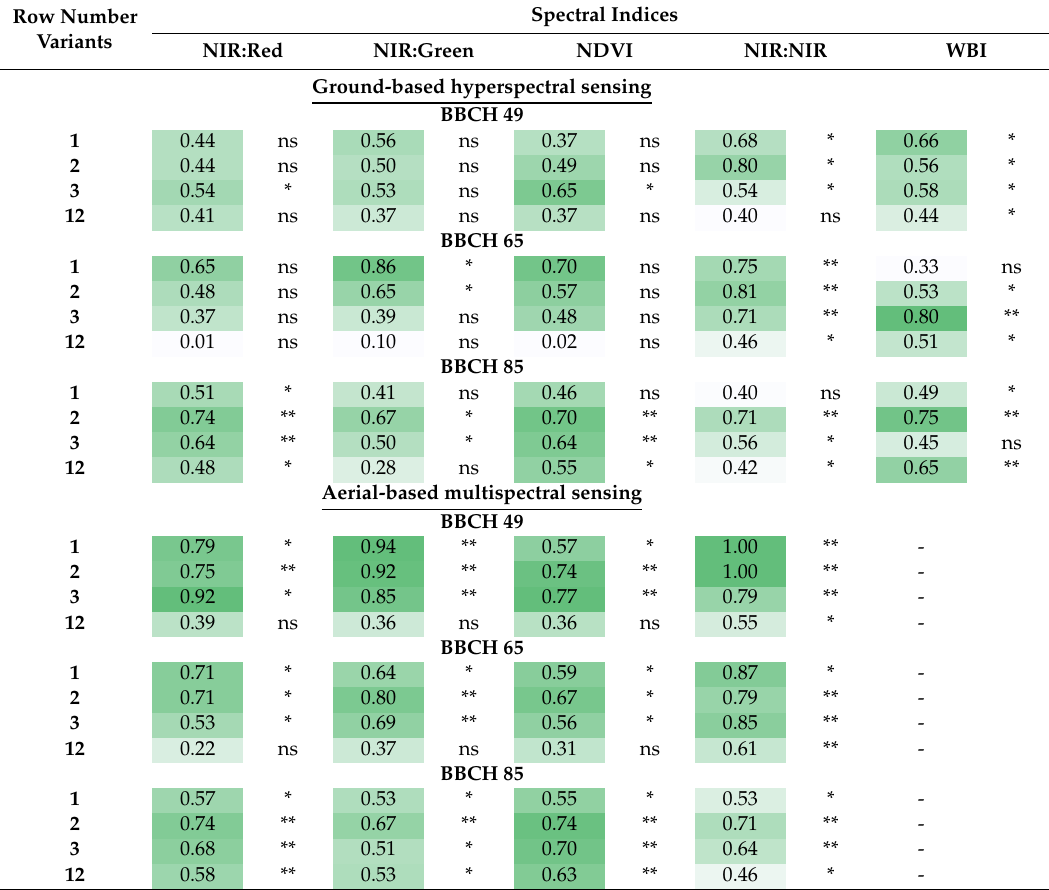
Table 4. Genetic correlation between the grain yield and spectral indices from ground- and aerial-based sensing in di ff erent row variants at BBCH scale stages 49, 65, and 85. Row Number